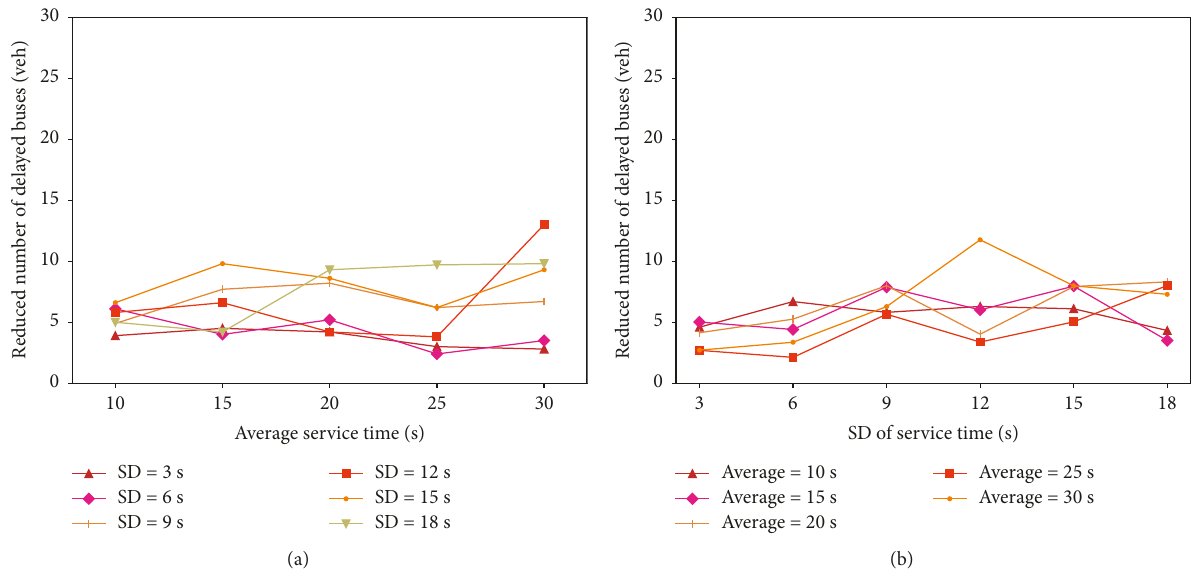
Figure 12: Impacts of service time on numbers of delayed buses: (a) SD of service time and (b) average service